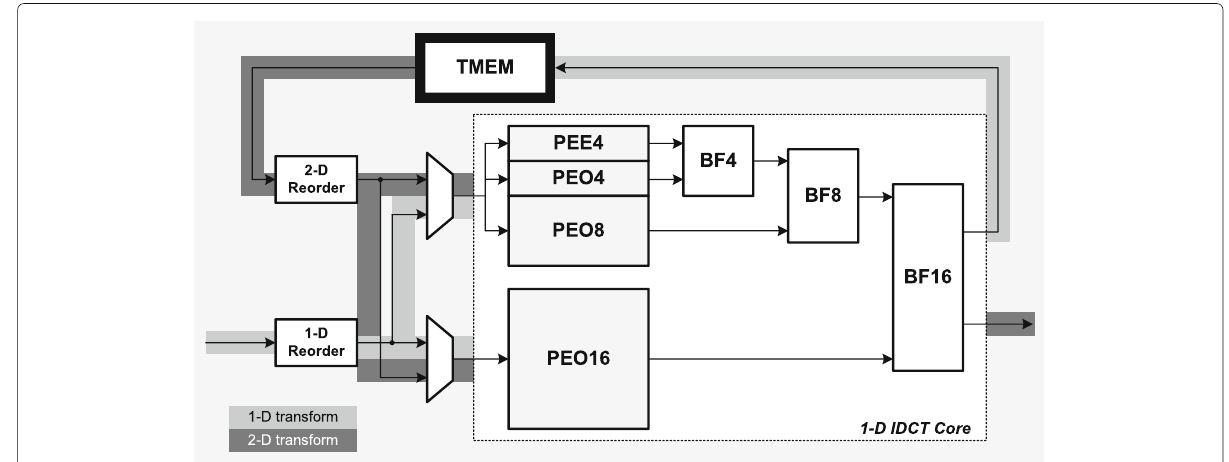
Fig. 2 Architecture of the proposed two-dimensional (2-D) IDCT